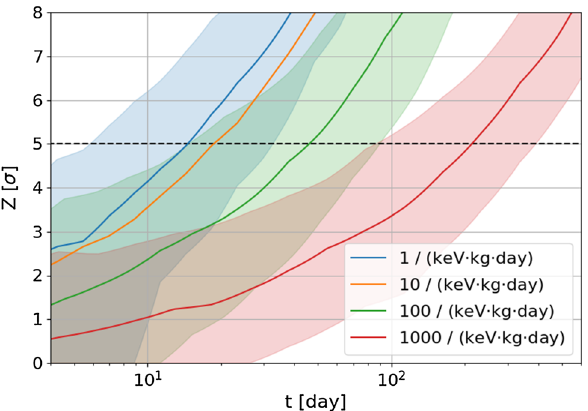
Fig. 11 Statistical significance of CE ν NS observation as a function of live time for NUCLEUS-10g, for different background indices, using the expected neutrino flux at the VNS and an energy threshold of 10 eV. For each background index, the median line and 90% probability bands (computedfrom600simulatedrandomspectraateachpoint)areshown. For the background index of 10 counts/(keV kg day), only the median line is shown for